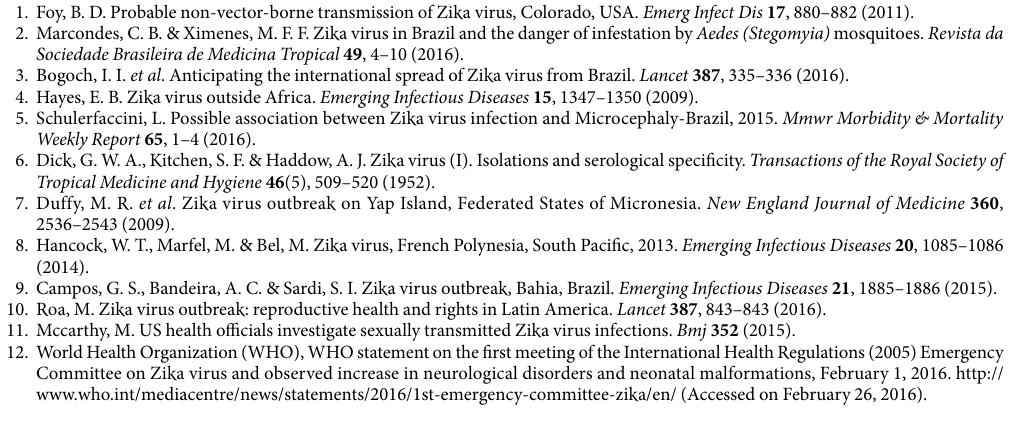
of suspected human cases of Zika in Brazil, good fitting results of model (4) are obtained. For the reemerging mosquito-borne flavivirus, there are no effective control measures due to many reasons, in this case the basic reproduction number R 0 = 2.5020, which is close to 2.055 (CI: 0.523–6.300) in literature 30 , where the term of R 0 concerning the sexual transmission is R HH = 0.0538 and mosquito vectorial transmission is R HV = 2.4750 which implies that mosquito vectorial transmission plays more important role in Zika transmission in Brazil while the effect of sexual transmission on the transmission of Zika cannot be neglected.